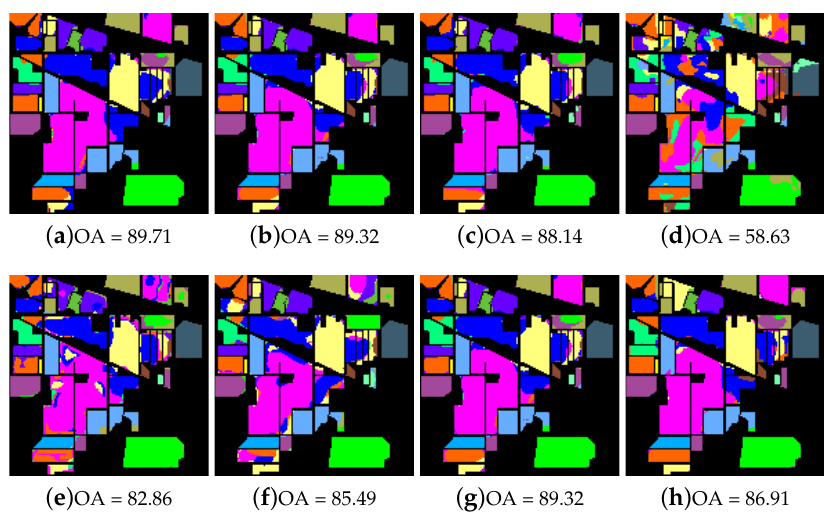
Figure 6. The analysis for the hyperparameters µ and S for the Indian Pines image. In the first row, S is fixed as five. ( a – d ) respectively show the classification results obtained by the extended label propagation (ELP)-RGF method with ( a ) u = 0.001, ( b ) u = 0.01, ( c ) u = 0.1 and ( d ) u = 1. In the second row, µ is fixed as 0.01; ( e – h ) respectively show the classification maps obtained by ELP-RGF method with ( e ) S = 1, ( f ) S = 3, ( g ) S = 5 and ( h ) S = 9.